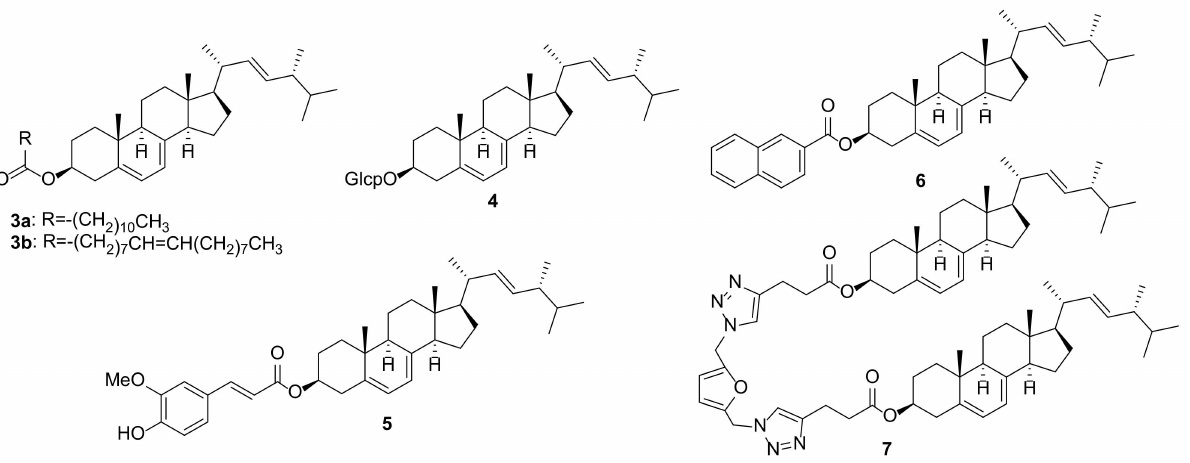
Figure 2. Structures of ergosterol O